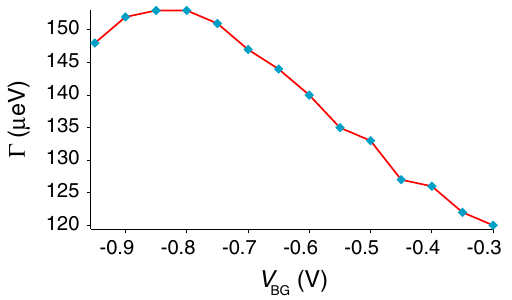
FIG. 3. Total hybridization (cid:1) vs backgate voltage V BG . Blue diamonds represent the determined (cid:1) from measured V K at different backgate voltages. This determination is performed in the middle of the Coulomb diamond of JJ1; see text for details. A control with 20% amplitude variations of (cid:1) is thus achieved by tuning the backgate. For visibility, error bars are not indicated here, but they are plotted in Fig. 6(a). Clearly, the backgate- voltage variation of the hybridization is not monotonous and can affect the left-right symmetry of the hybridization of the QD as well. This backgate-voltage range ( (cid:1) 0 : 3 V to (cid:1) 0 : 7 V ) is chosen in order to minimize the asymmetric change of the hybridization, which is a subleading effect compared to the exponential change of the Kondo temperature associated with the variations of (cid:1)